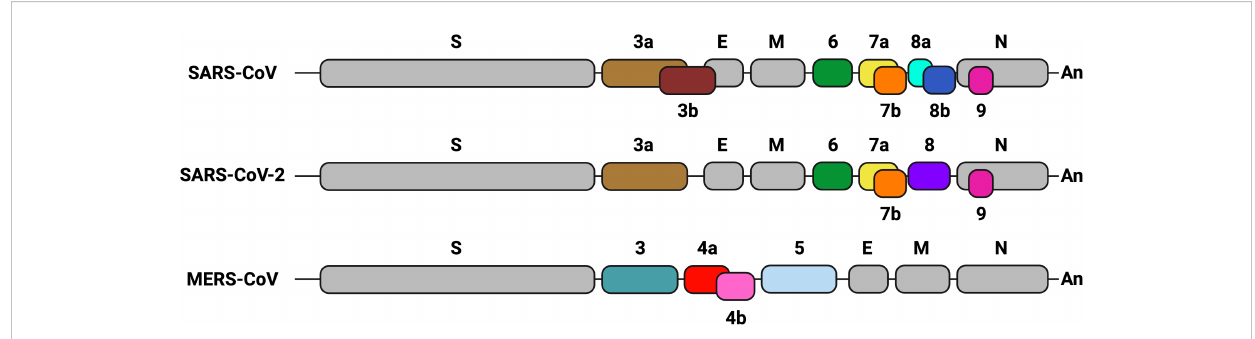
FIGURE 1 Genetic organization of the genome 3 ’ end in highly pathogenic human CoVs. Structural and accessory genes are shown. Gray boxes indicate structural genes: spike (S), envelope (E), membrane (M) and nucleocapsid (N). Accessory genes are represented in different colors. Their names are indicated as numbers above or below the boxes. Sequence conservation of accessory genes is indicated with the same color. The Poly A sequence (An) is represented at the 3´end of each CoV genome. Created with